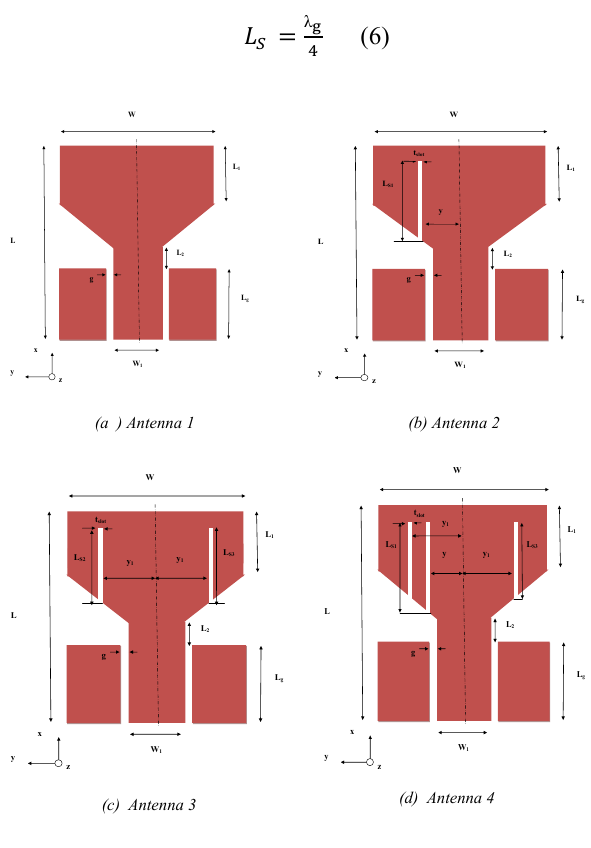
Figure 4: Steps of improvement of the proposed antenna. Three slots with the same line width t slot were embedded in